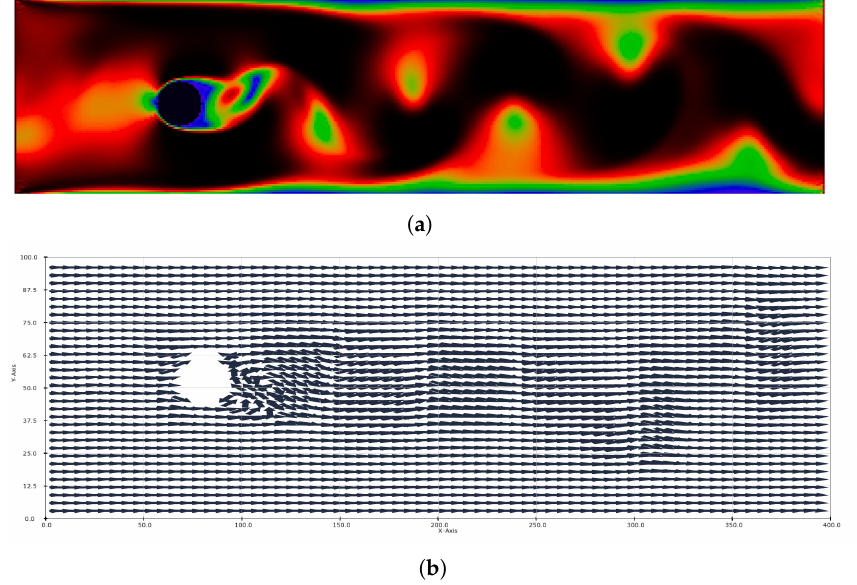
Figure 4. Kármán vortex street (channel flow past circle-shaped obstacle) test case at 1000 × 300 resolution after 5000 iterations. ( a ) Visualization of Kármán vortex street simulation; ( b ) Velocity vector field (filtered for better